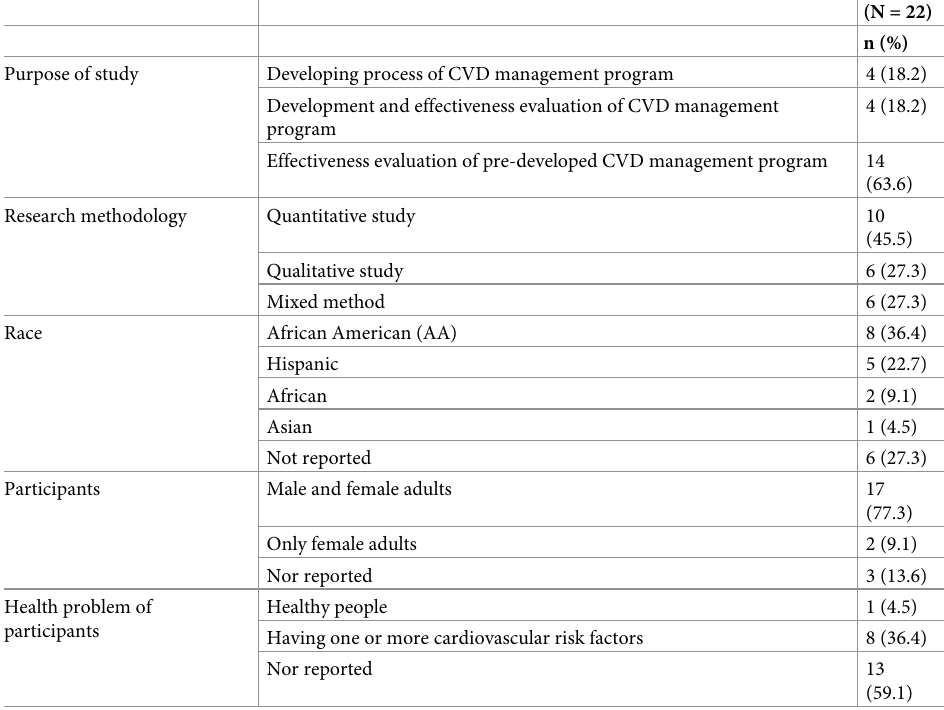
Table 2. General characteristics of selected study.